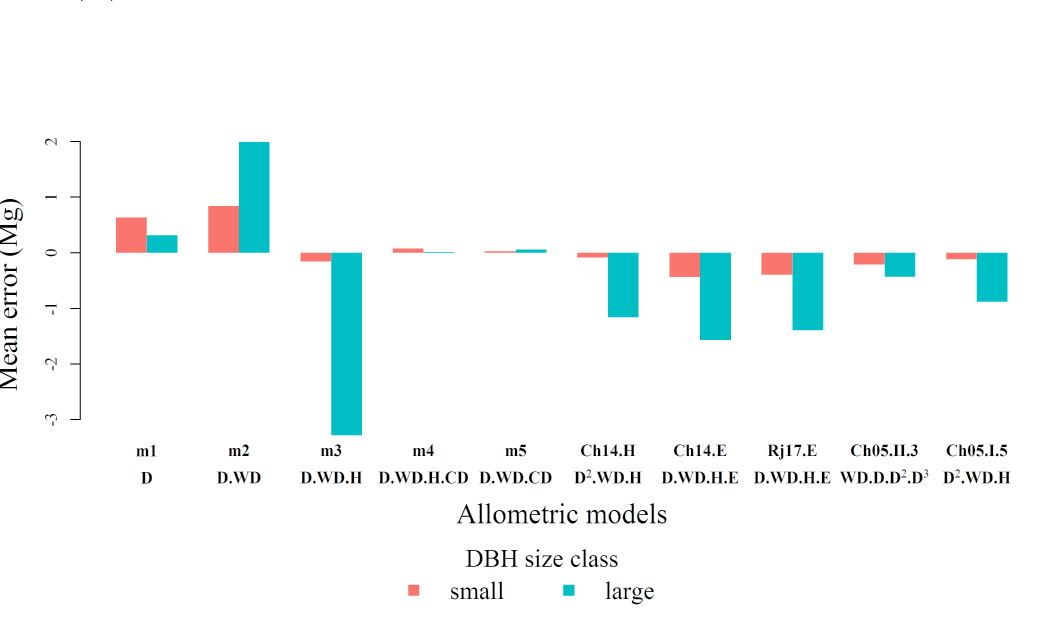
Figure A2. Mean error in estimates (estimated AGB minus reference AGB in Mg) by DBH size class: small trees (D ≤ 70cm; n = 17) and large trees (D > 70cm; n = 9) for the TLS-derived allometric models and pantropical